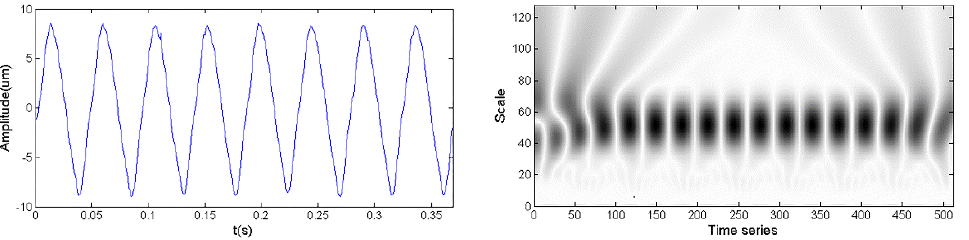
Figure 2. Time domain waveform and CWTS of a normal signal.